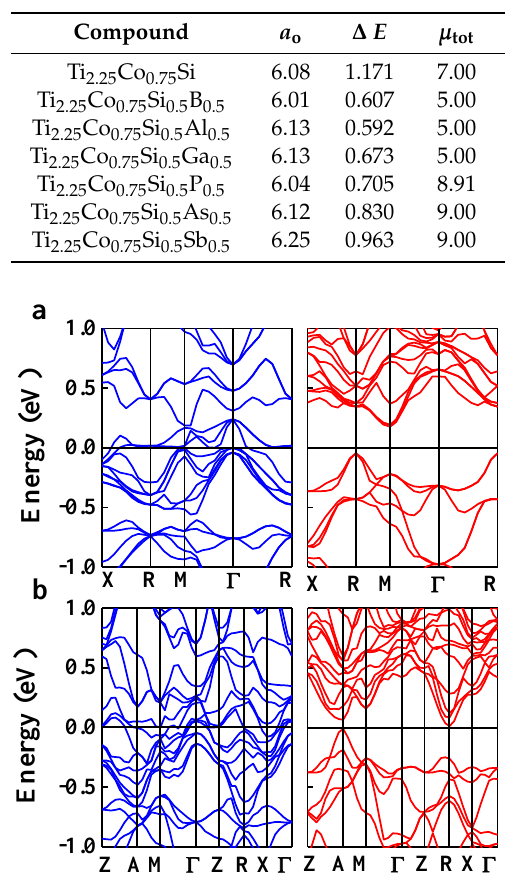
Figure 3. Spin-resolved electronic band structures of Ti 2.25 Co 0.75 Si ( a ) at an equilibrium lattice constant and ( b ) with c/a = 1.12 lattice distortion. The zero of the energy scale is set at the Fermi energy. The blue and red solid lines represent spin-up and spin-down states, respectively.